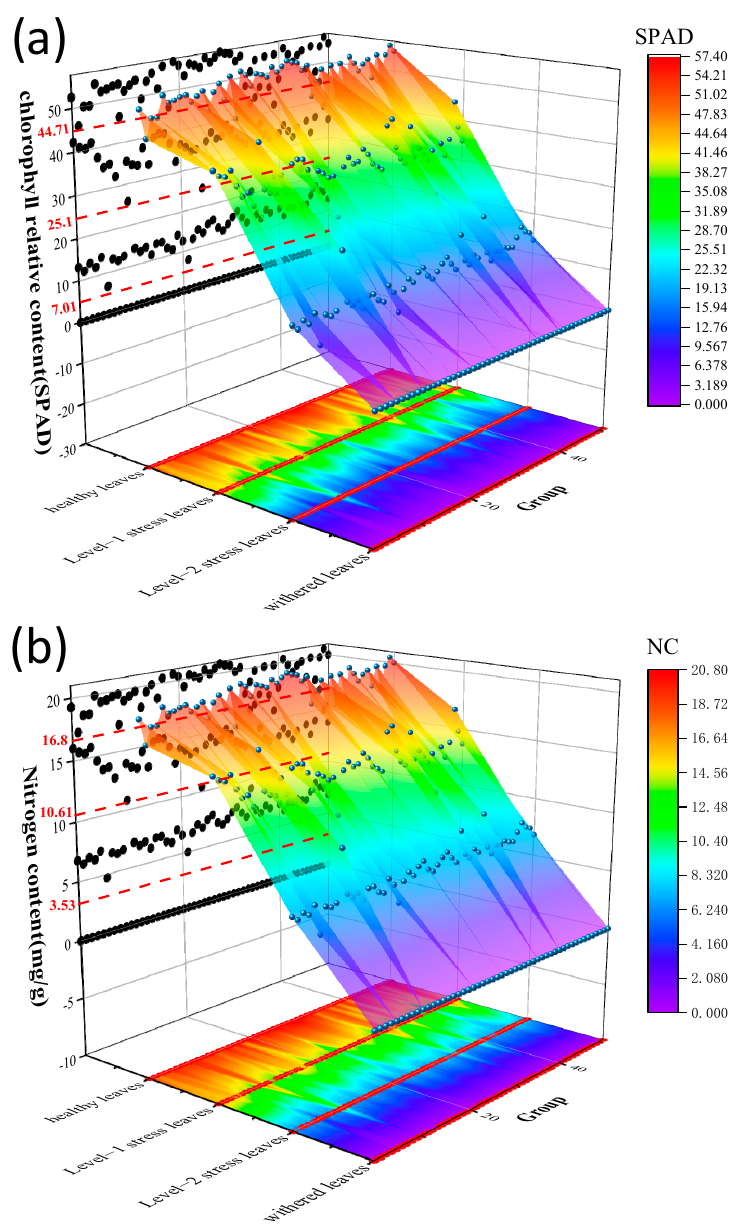
Figure 15. ( a ) 3D scatter plot of the chlorophyll content. ( b ) 3D scatter plot of the nitrogen content.